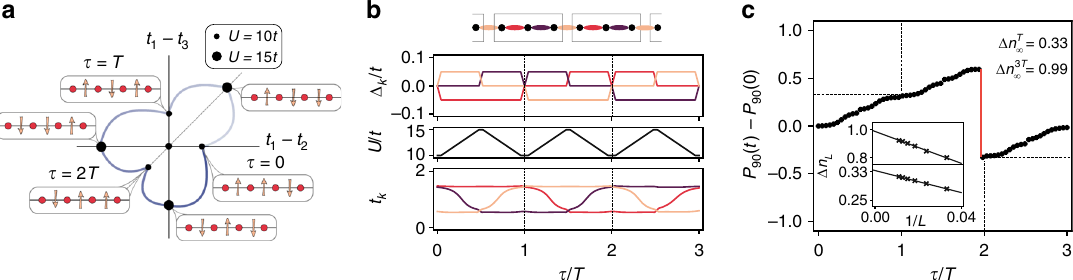
Fig. 5 Self-adjusted fractional pumping: a the trivial and topological BOW phases are threefold degenerate each. The six different states are represented here as different points on an effective parameter space characterized by the expectation values of the bond fi elds t k ¼ 1 þ α = t h σ z k ; k þ de fi ne an adiabatic cycle through these different BOWs, the protecting inversion symmetry must be broken at intermediate states in order to enclose the degeneracy point at t 1 = t 2 = t 3 . b The Peierls mechanism forces the system to break this symmetry spontaneously when interactions are increased, connecting states in the trivial and topological BOW phases (Fig. 3b). In order to select which state from the degenerate manifold the system will transition to, we introduce an external inhomogeneous Z 2 fi eld Δ k that is only applied to a subset of bonds within the unit cell. The fi elds partially break the degeneracy of the BOWs, and restrict the possible adiabatic evolution. A sequential combination of local fi elds and interaction-driven self-adjustments allows the system to cycle around the degeneracy point in the effective parameter space. Note that the protocol must be repeated three times for the ground state to reach the initial con fi guration. c COM P L ( t ) through the cycle for a fi nite chain of size L = 90 and for β = 0.025 t . The discontinuous jump (red), related to the presence of edge states, allows us to obtain the total charge transported in the bulk during one cycle, Δ n L = 90 = 0.92. Inset: fi nite-size scaling yields a transported fractional charge at τ = T , and an integer charge at the end of the adiabatic path ( τ = 3 T